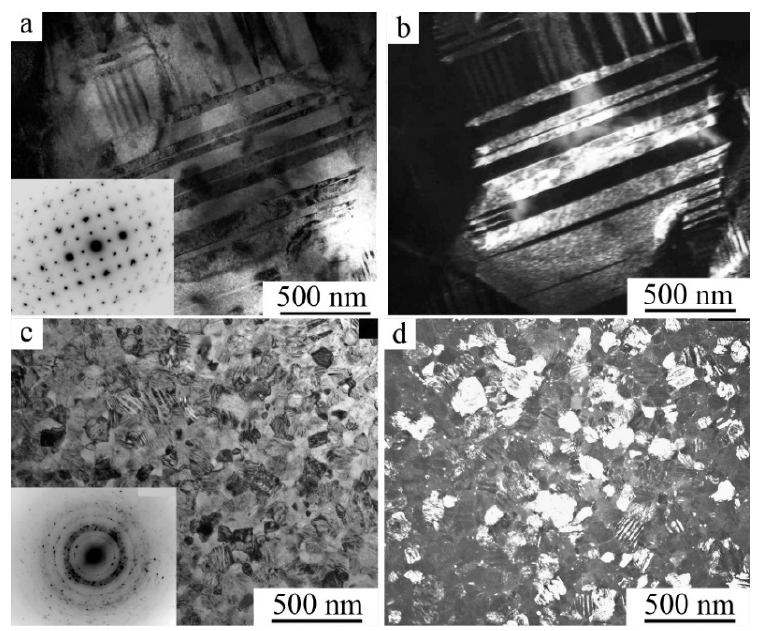
Figure 13. TEM images and corresponding SAEDs of rapid quenching from melt (RQM) alloys ( a , b ) Ti 50 Ni 25 Cu 25 and ( c , d ) Ni 45 Ti 32 Hf 18 Cu 5 obtained in an amorphous state and subjected to various crystallization annealing.